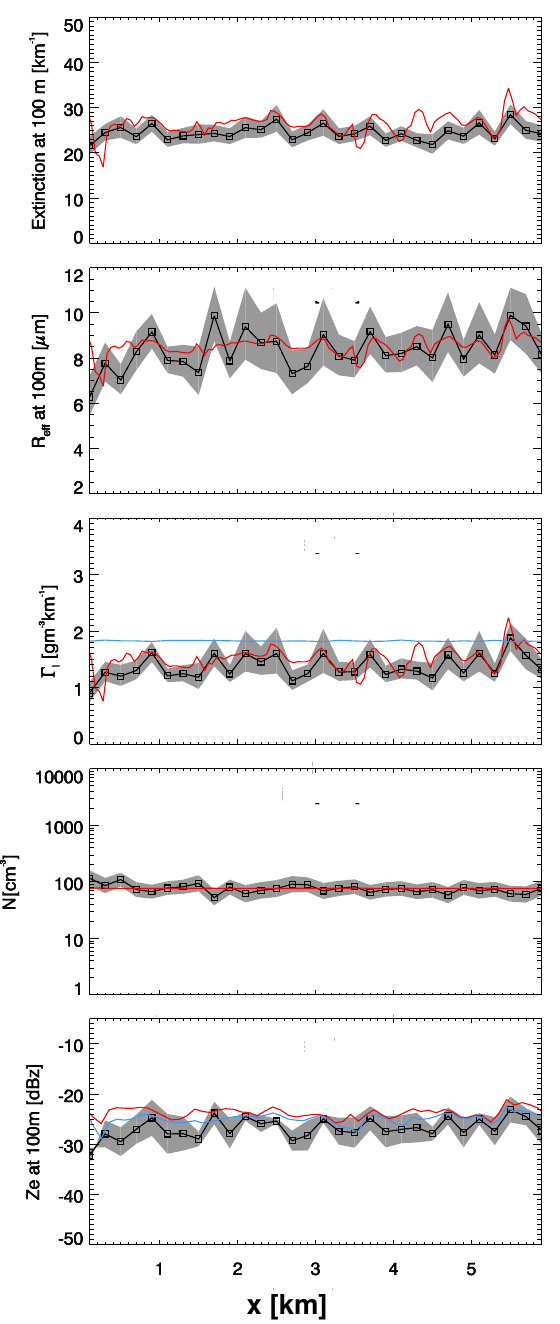
Figure 11. Results of the retrieval applied to the simulated lidar data along with the radar reflectivity simulated using the lidar re- sults. Here the black lines show the retrieval results with the grey bands indicating the estimated 1-sigma uncertainty range. The red lines show the true values extracted directly from the LES-derived model fields. The light-blue line in the LWC panel indicates the value of the adiabatic ( (cid:48) l ) slope at cloud base. The light-blue line in the reflectivity panel indicates the true reflectivity levels if the contribution of the drizzle mode is